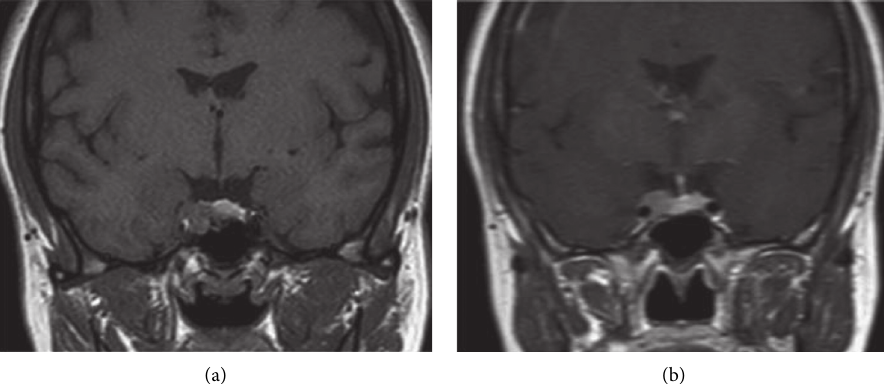
Figure 2: Pregadolinium (a) and postgadolinium (b) T1-weighted coronal images of pituitary MRI showing 10mm adenoma with right cavernous sinus invasion.